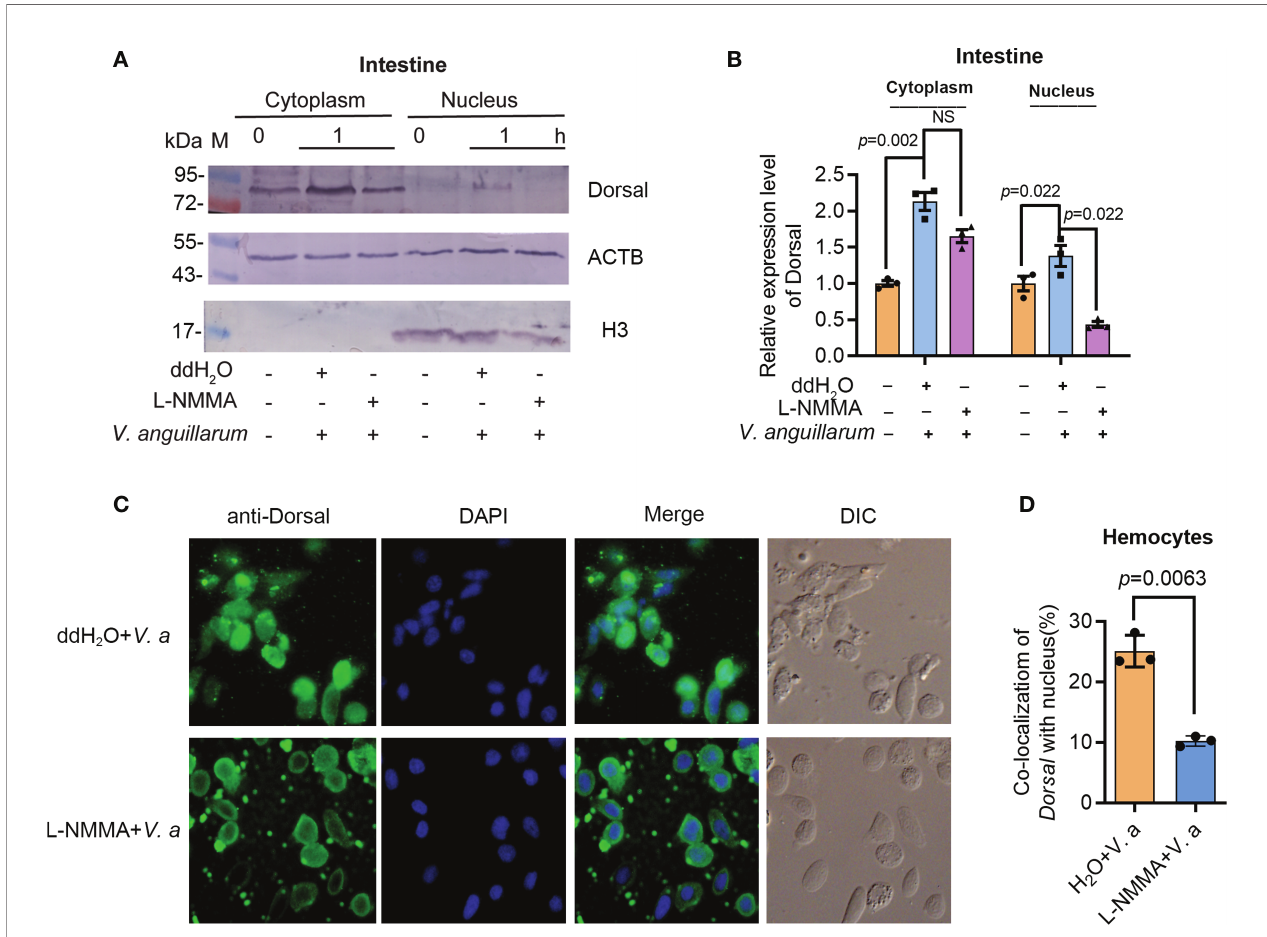
FIGURE 8 | Activated ERK by NO signal is responsible for dorsal phosphorylation and translocation into the nucleus of hemocytes in shrimp. (A) The distribution of dorsal in the nucleus and cytoplasm of intestine cells after treatment with L-NMMA and V. anguillarum ; ddH 2 O was used as the control; ACTB and histone 3 were used as loading controls. (B) Statistical analysis of the data from three experiments digitalized by ImageJ and statistical analyzed by Student ’ s t -test. (C) Subcellular distribution of dorsal in hemocytes of L-NMMA-treated shrimp challenged by V. anguillarum analyzed using fl uorescent immunocytochemistry. The nuclei of hemocytes were stained using DAPI. (D) Statistic analysis of colocalization of dorsal with nucleus using WCIF ImageJ software. DIC, differential interference construct. Signi fi cance differences were analyzed using Student ’ s t-test and signi fi cant differences were accepted at p < 0.05. NS, no signi fi cant